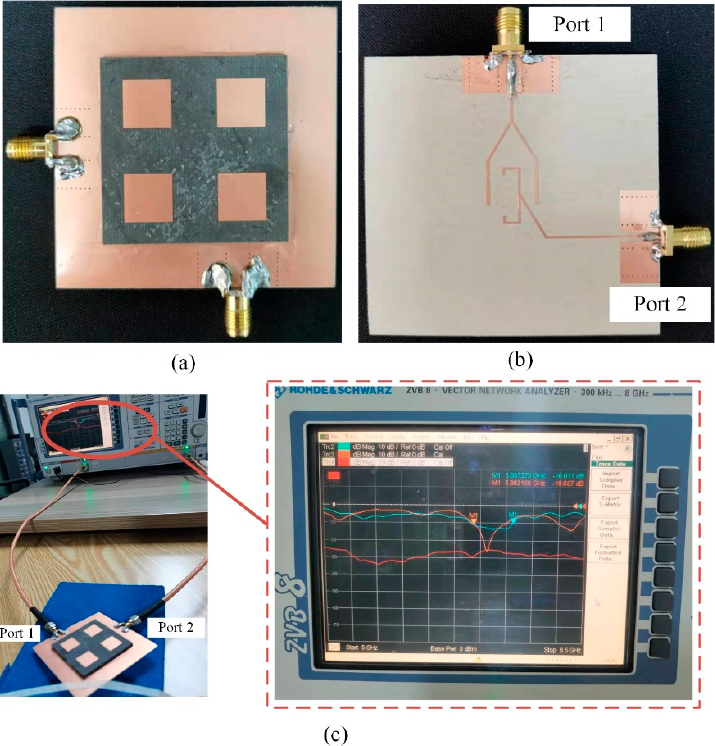
Figure 10. Photos of the proposed antenna and the measured setup. ( a ) Top view. ( b ) Back-side view. ( c ) Test setup.